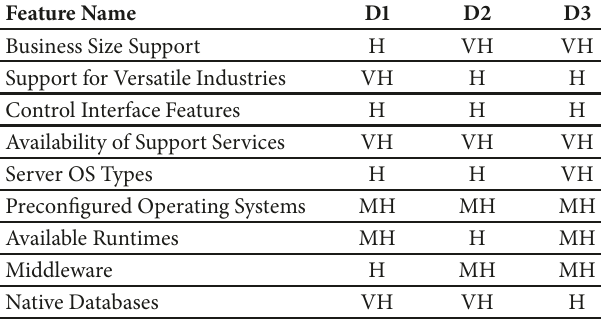
Table 1: Criteria assessed by decision